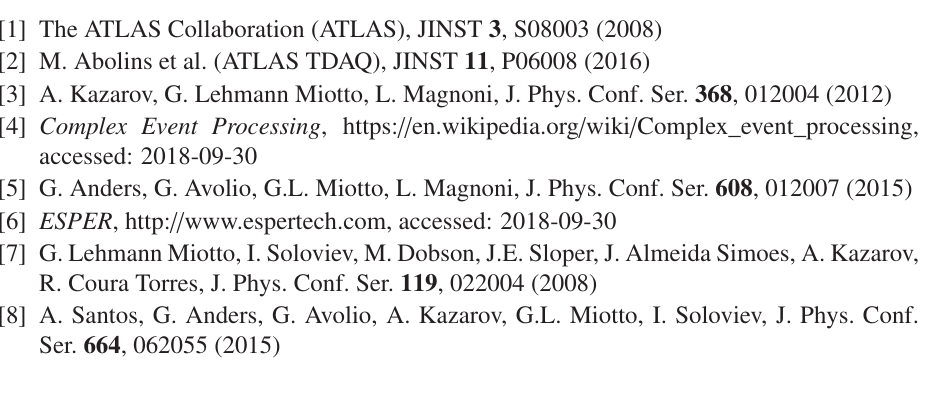
able to apply a set of 290 EPL directives to the streams of TDAQ operational data of O (10 5 ) updates per second in a real-time manner. SA knowledge base is developed and maintained by TDAQ and subsystem experts on daily basis, addressing new operational issues as they arrive. SA Replay is an important application for validation of SA directives. Introduction of SA in LHC Run 2 greatly reduced the operational load on the collaboration, with decreased dependence on experts and removal of one control room shift